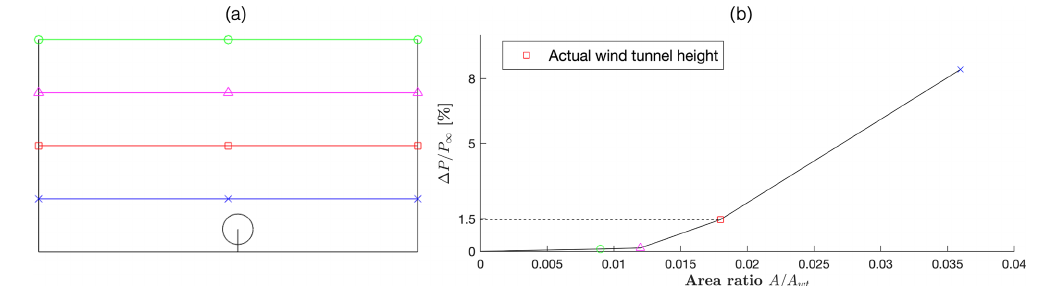
Figure 14. Wind tunnel blockage effect. (a) Cross-sectional areas. (b) Percent power increase with respect to the unrestricted flow vs. area ratio A/A wt .